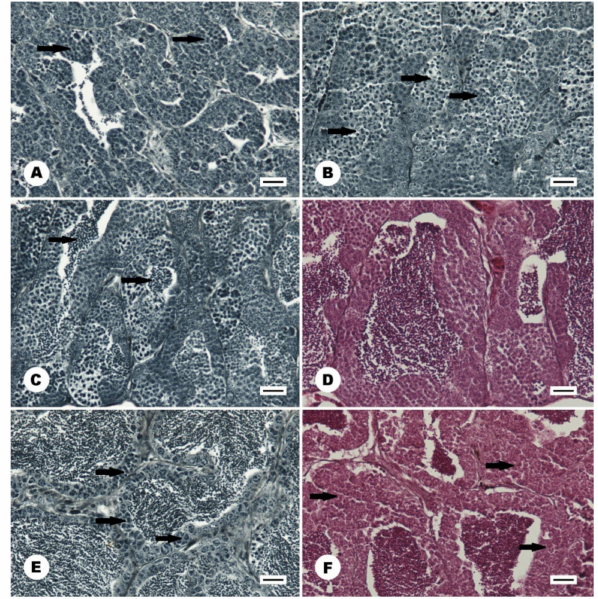
Figure 8. Histology of the gonad in the male stone moroko ( Pseudorasbora parva ) inhabiting Wardynka river, Poland. ( A ) gonad in later stage II L , the tubules contain numerous cyst with multiplying spermatogonia B (arrow), August; ( B ) Stage III E , the meiotic division has begun, and primary spermatocytes were formed in cyst (arrow), January; ( C ) Stage III L , all type of spermatogenic cells are visible in the gonad, first spermatozoa are formed (arrow), April; ( D ) The spawning stage IV, the tubule lumen is filled with spermatozoa, by the tubule wall numerous cysts with maturing cell occurred, April; ( E ) The spawning stage V-II, the gonad with finalised spermatogenesis, tubules filled with spermatozoa, the tubule wall contains resting type A spermatogonia and multiplying type B spermatogonia (arrow), June; ( F ) a spent gonad in stage VI-II. Shrunken tubules filled with unexpelled spermatozoa. The tubule wall contains type A spermatogonia and cysts with type B spermatogonia (arrow), June. Scale bar 20 µ